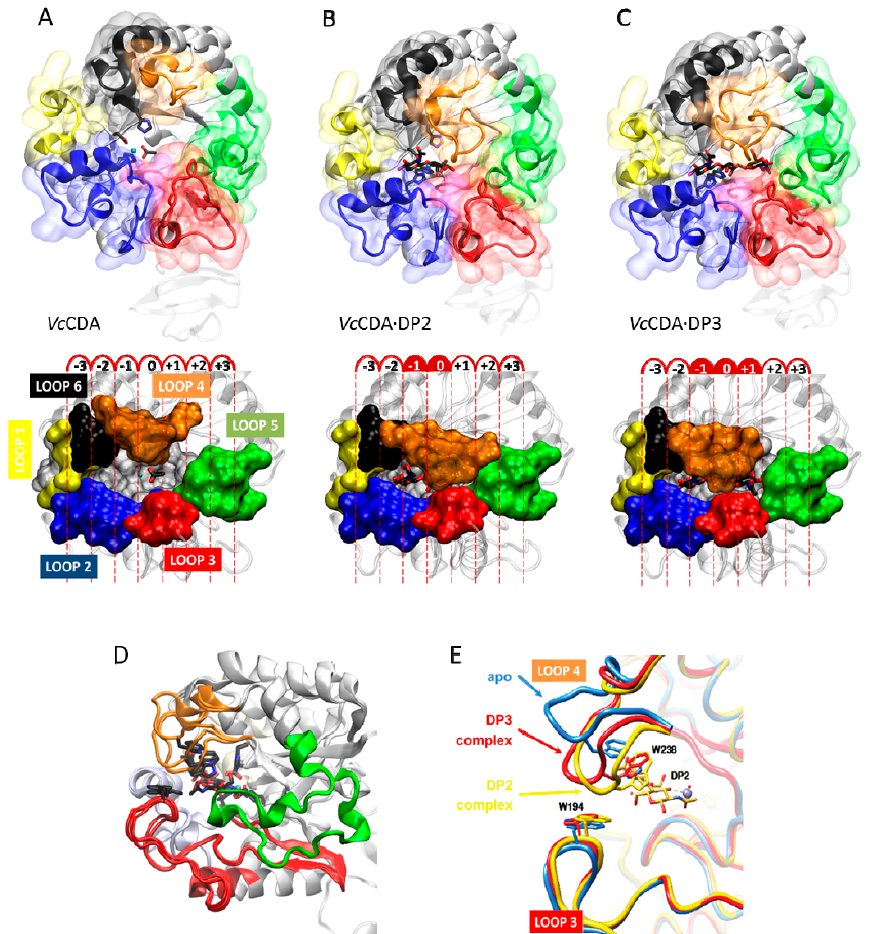
Figure 7. Crystallographic structure of ( A ) Vc CDA in the unliganded form (free enzyme with Zn 2+ and acetate); ( B ) Binary complexes with DP2; and ( C ) DP3 ligands; ( D ) Superimposition of the three structures. Loop 4 (brown) has different conformations; ( E ) Magnification of the active site Loop 4 in the unliganded form (blue), and in enzyme–substrate complexes with DP2 (yellow) and DP3 (red) ligands. Only the DP2 ligand is